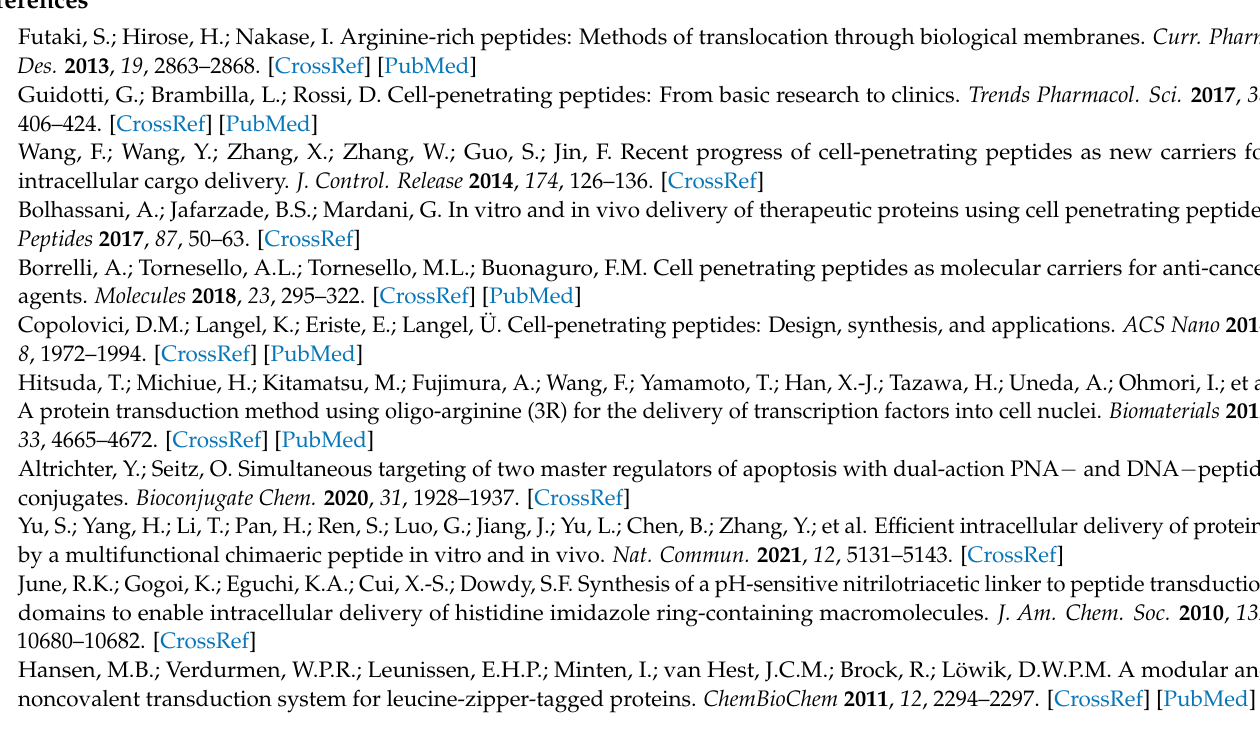
Table S1: Synthesized peptides used in this study: Nomenclature and